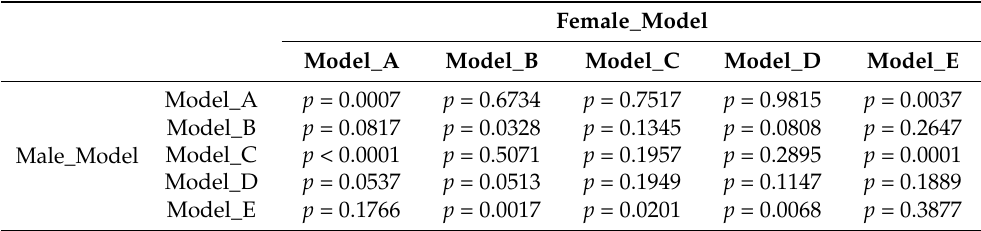
Table 7. Wilcoxon rank sum